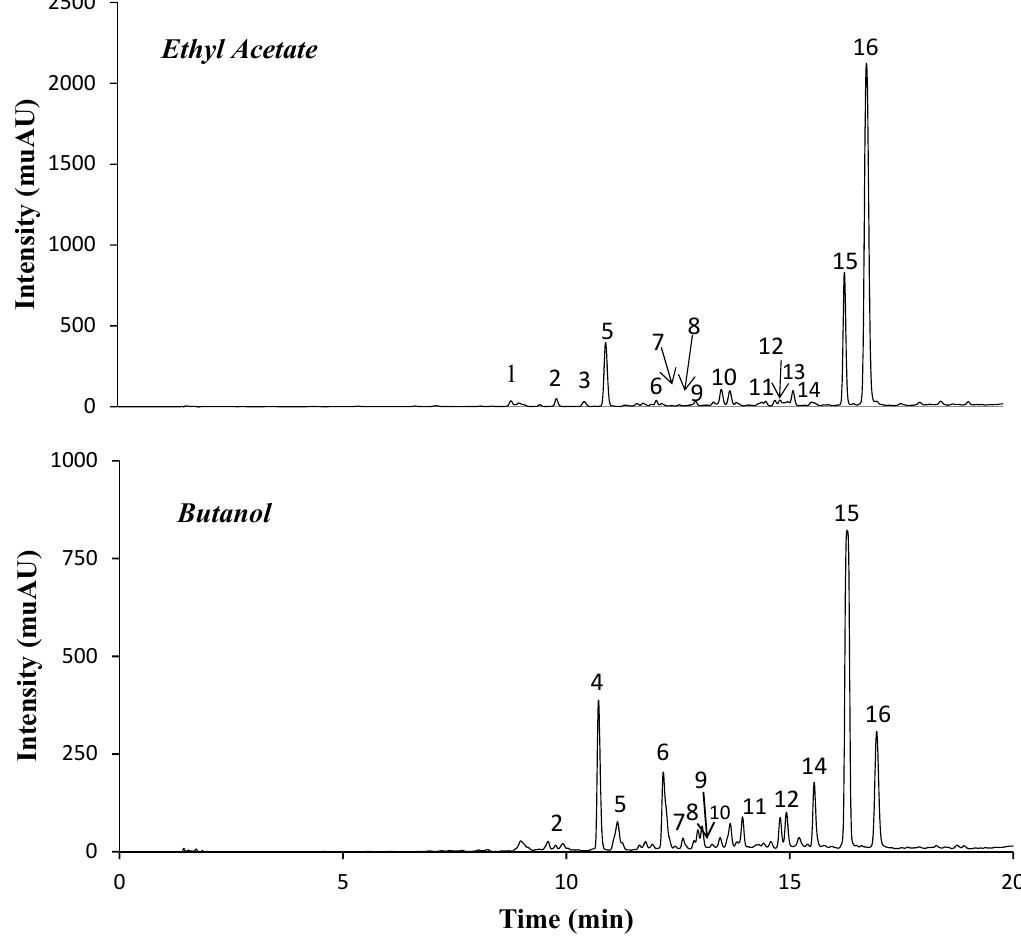
Figure 1. Chromatographic representation of Scrophularia tenuipes fractions at 280 nm. Numbers in the figure correspond to the UHPLC-DAD-ESI-MS n peaks described in Table